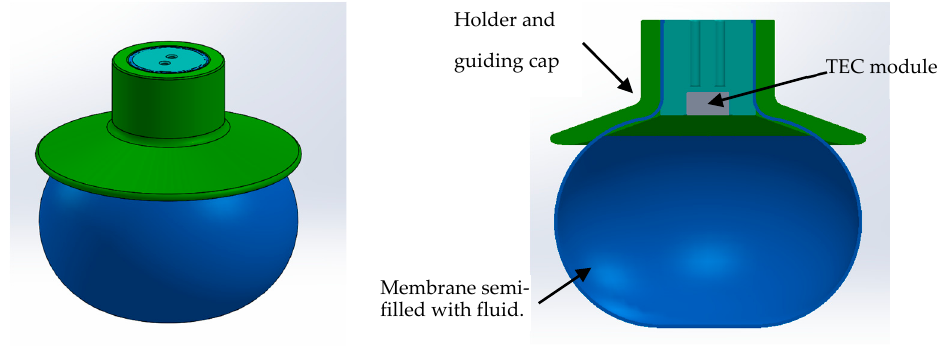
Figure 1. Liquid jamming gripper: concept design.